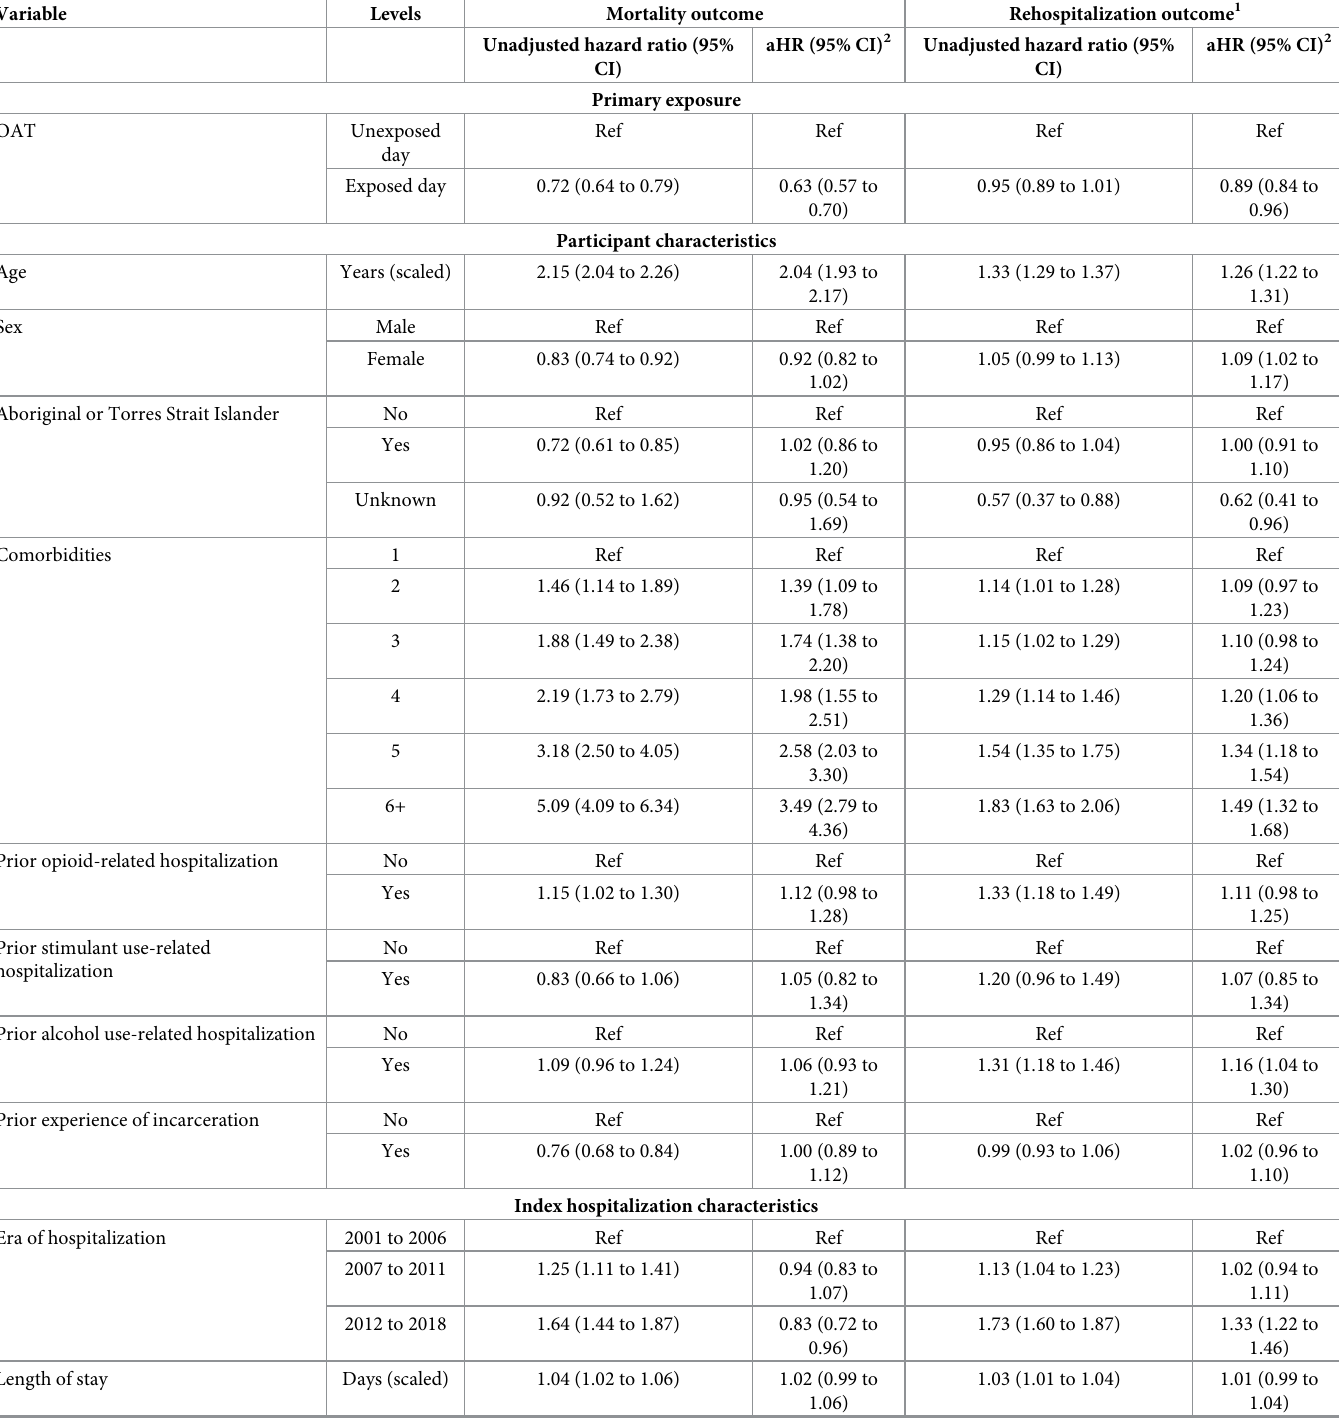
Table 2. Results of Cox regression for survival following discharge from index hospitalization with an injecting-related bacterial or fungal